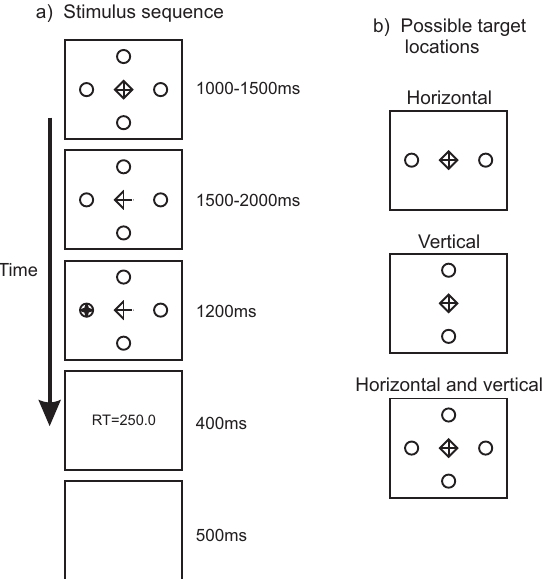
Figure 1 . a) Stimulus sequence. A fixation symbol was pre- sented together with two or four place-holder circles for a duration between 1000ms and 1500ms, after which two of the lines of the fixation symbol were removed, turning it into an arrow. After a delay of between 1500ms and 2000ms, the target (a star-shape) was presented inside one of the place- holders. Once a saccade was detected after target onset, the stimuli were removed from the screen and feedback on the reaction time was provided for 400ms. A blank screen pre- sented for 500ms served as the inter-trial interval. The stimuli are illustrated in reverse contrast (in the experiment stimuli were presented in white on a dark background). b) Illustra- tion of the possible target locations, indicated by the locations of the place-holders. Either targets appeared along the hori- zontal axis, along the vertical axis, or along the horizontal and vertical